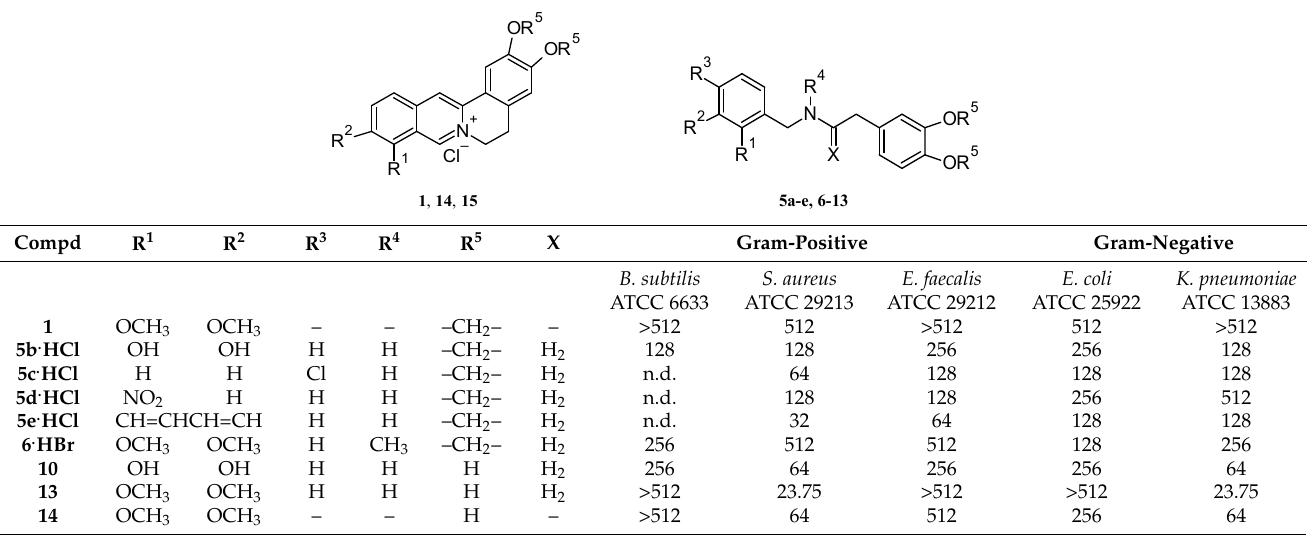
Table 1. Antibacterial activity (MIC, µg/mL) of berberine ( 1 ), berberine analogues ( 5a–e , 6 – 10 , 12 , 13 ), and berberine derivatives ( 14 , 15 ).